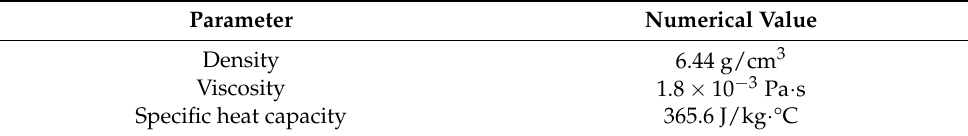
Table 2. The parameters of the lubricant.